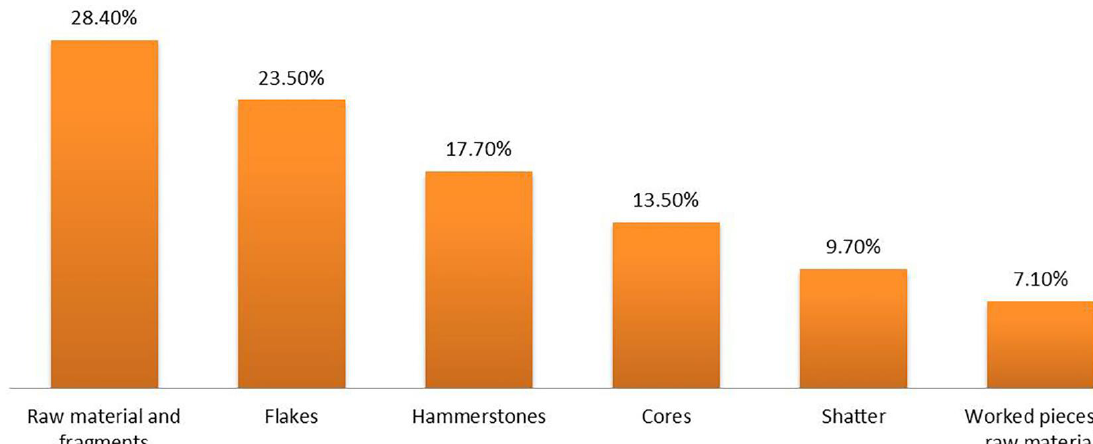
Figure 5. General structure of Cluster 1 (Lojanik 1).